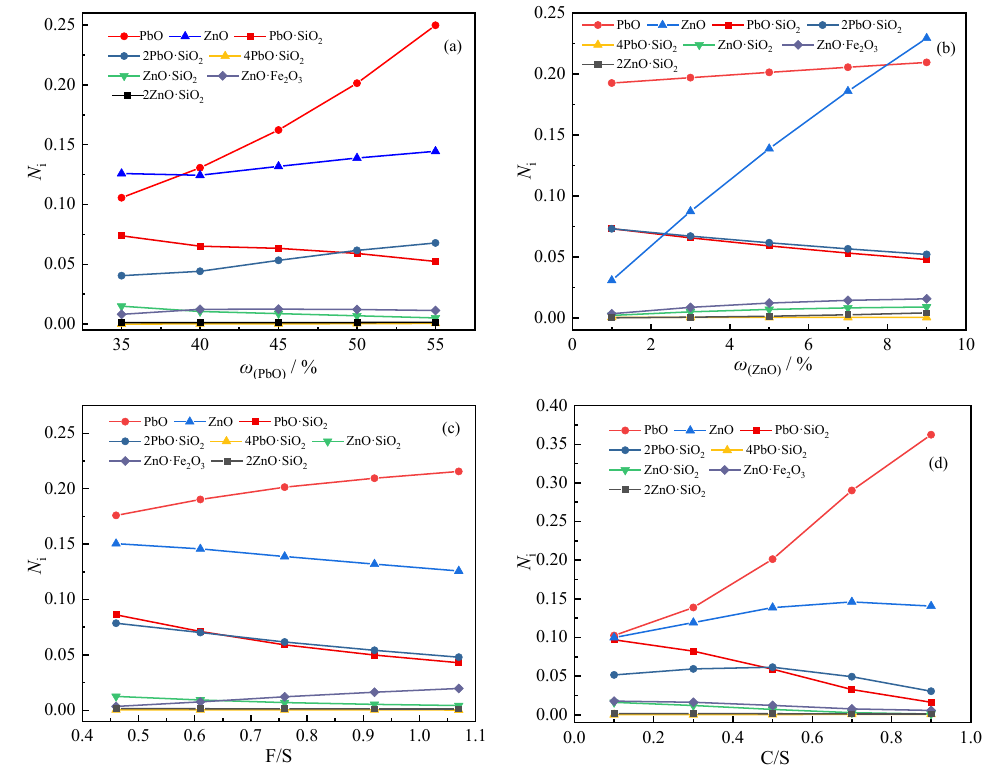
Figure 5. Activity of lead and zinc compounds in slags with different compositions: ( a ) mass fraction of lead; ( b ) mass fraction of zinc; ( c ) iron-silicon ratio; ( d ) calcium-silicon ratio.